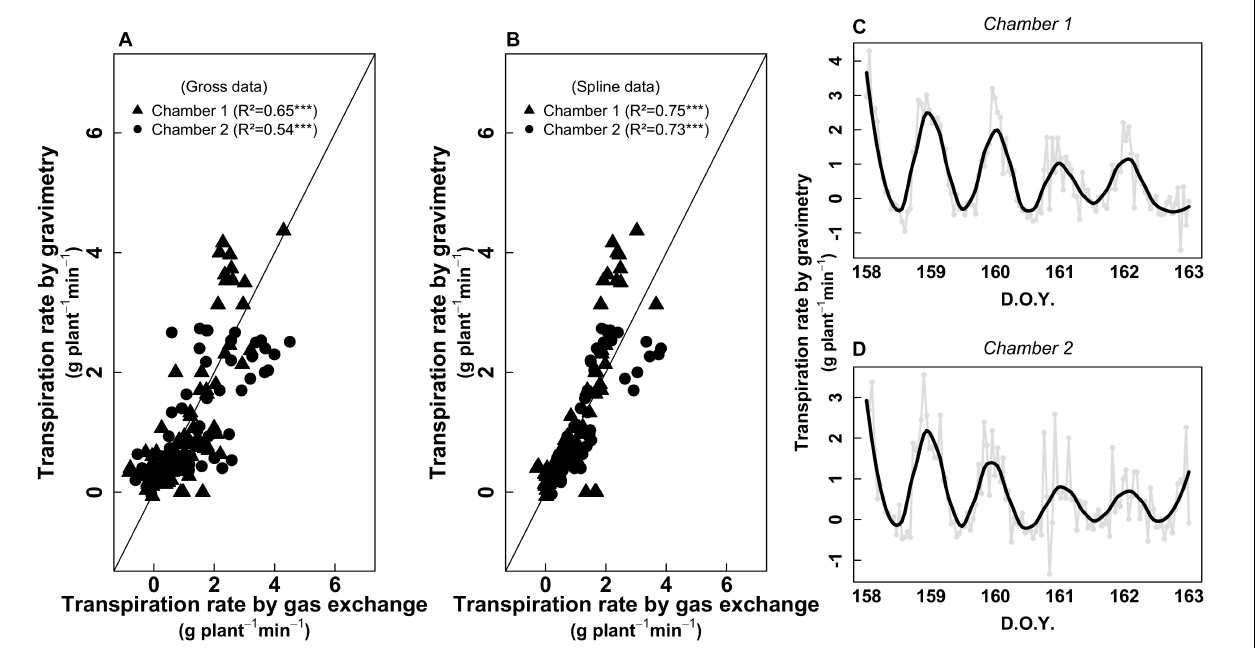
FIGURE 2 | (A) Relationship between Transpiration rate (g H 2 O plant − 1 min − 1 ) estimated from gravimetry and gas exchange (whole-plant chamber). The continuous line represents the 1:1 relationship. (B) Same relationship but with data treated with a spline. The continuous line represents the 1:1 relationship. (C,D) gross data of gravimetry [gray circles and lines, same as presented in (A) ] for chambers 1 and 2, respectively. The black lines represent the data treated with a spline in order to remove non-biological noise, as presented in (B) . The data in (A,B) come from two sampling sessions (first session: from D.O.Y. 143–150; second session: from D.O.Y. 158–163; see Figure 1 ).